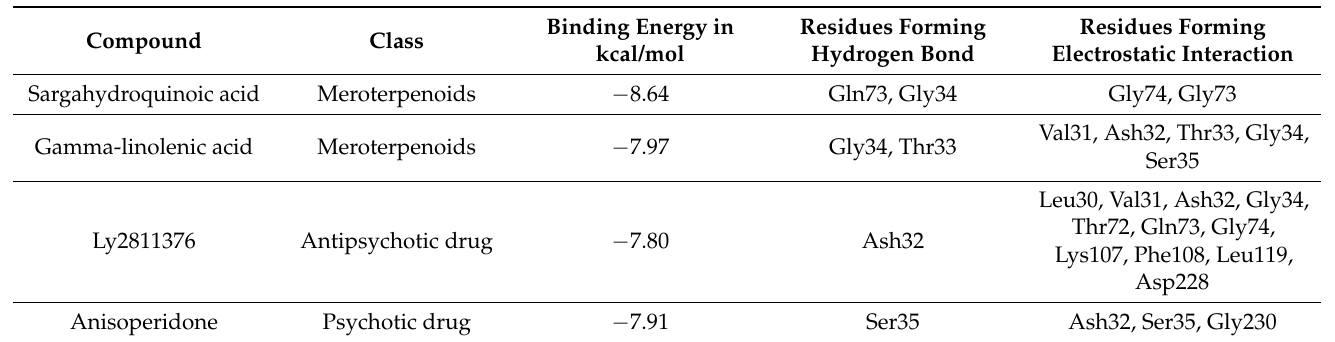
Table 2. Predominant interactions of some of the docked compounds including their binding